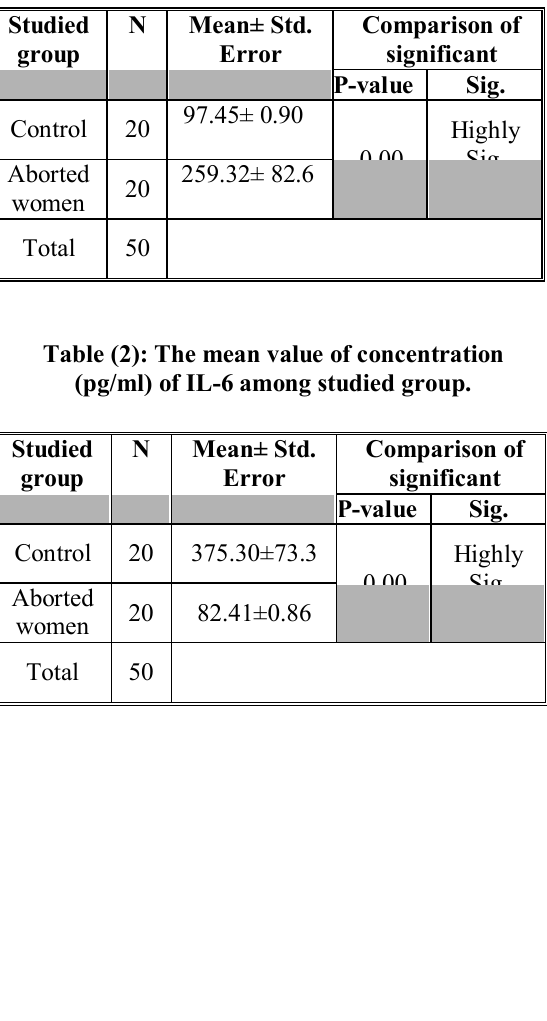
Table (1): The mean value of concentration (pg/ml) of IL-2 in sera of studied group.